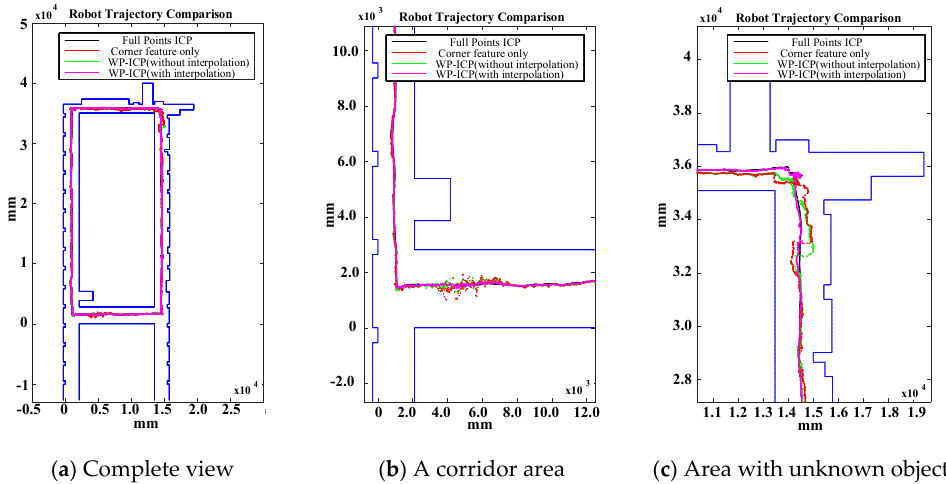
Figure 16. Experiments under different algorithms in the DAA-3F.